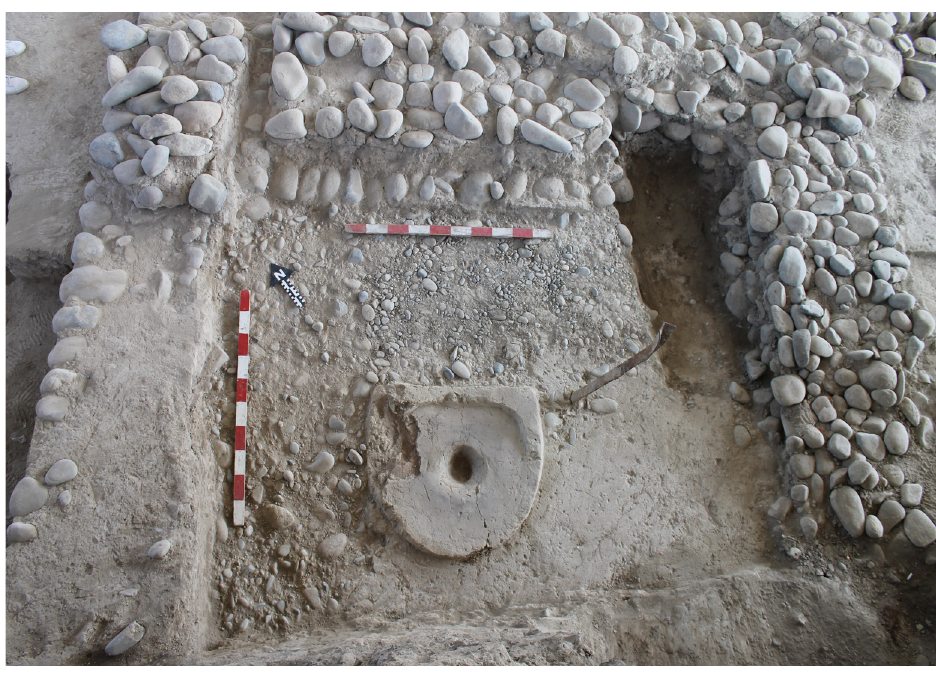
Fig. 7: The flame shrine in Room B of Building 1.